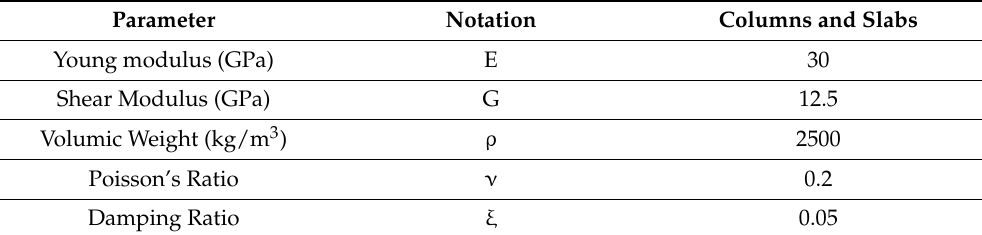
Table 2. Material properties considered for the structural elements in the building.